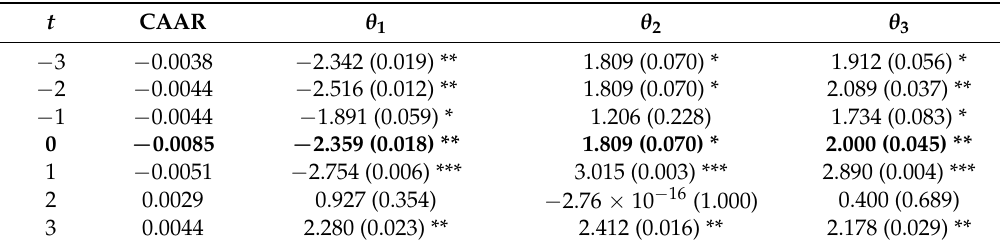
Table 5. Stock market reactions to Brexit, SEE regional factor, three-day window length.